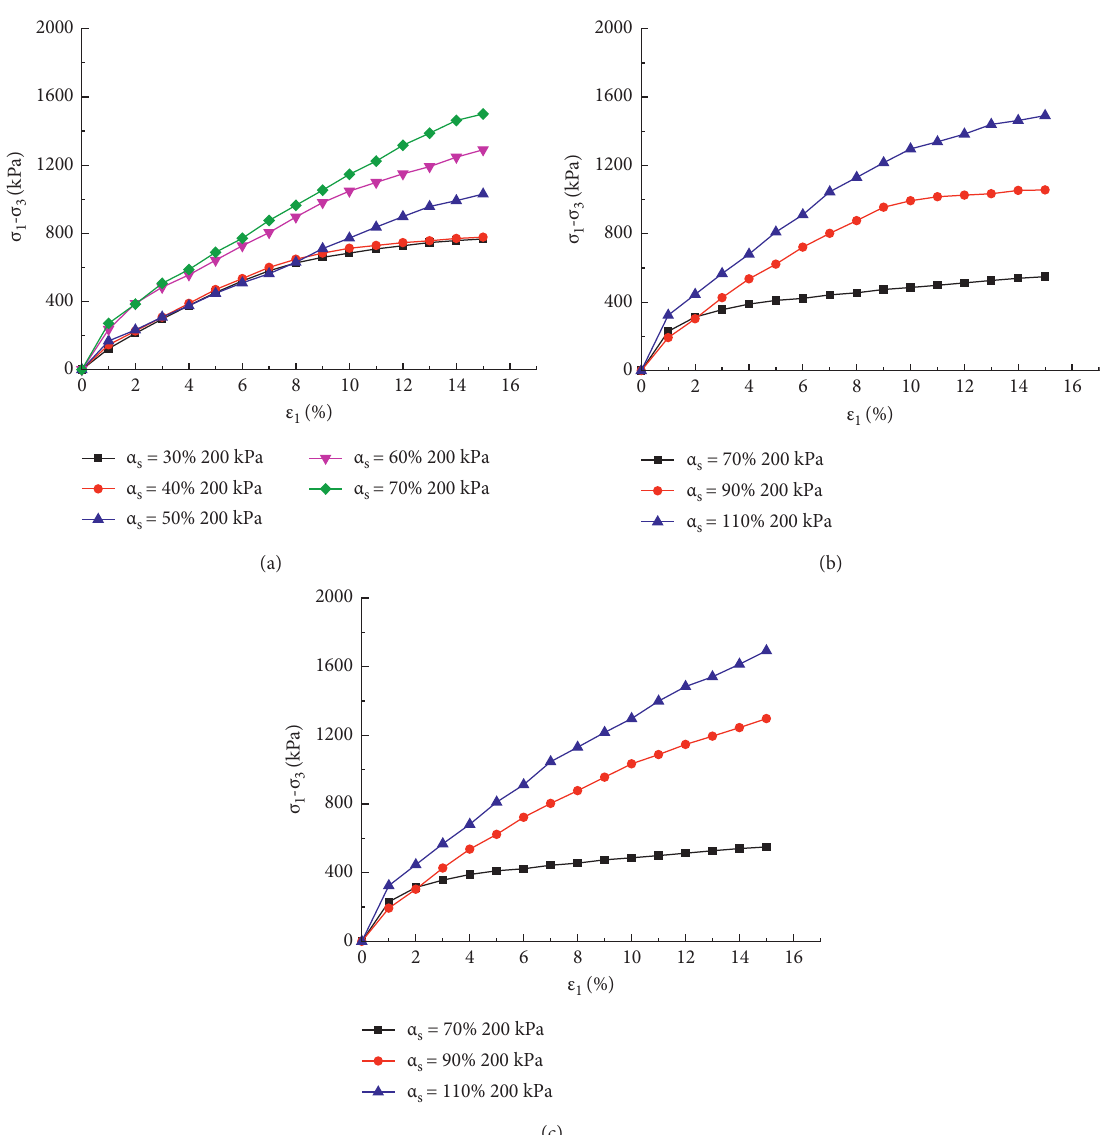
Figure 10: Stress and strain curve of the sample under different water content. (a) ω � 50%. (b) ω � 70%. (c) ω �